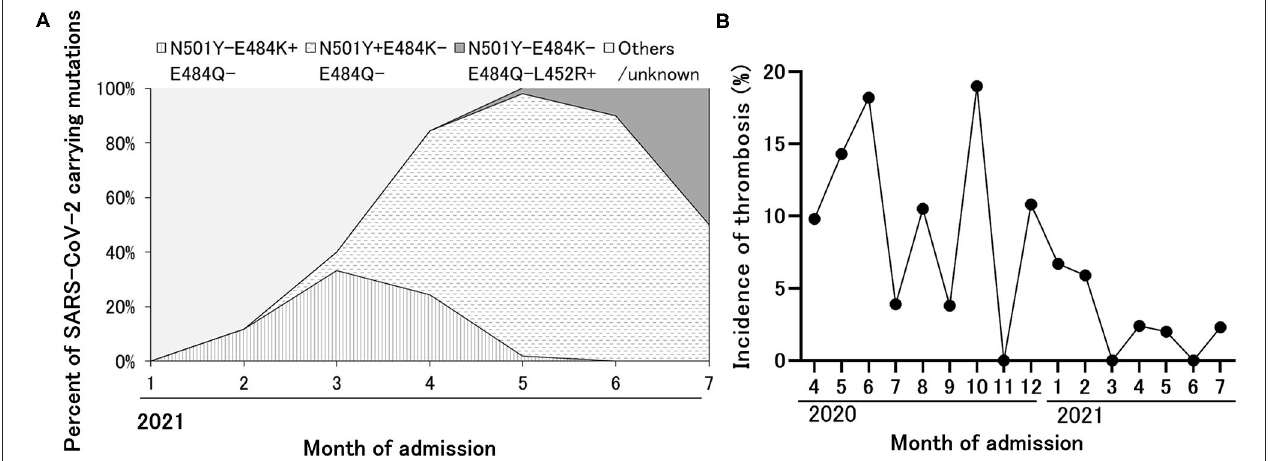
FIGURE 3 | The replacement of SARS-CoV-2 strain to VOC/VOI during the observation period and decreased incidence of thrombosis over time. (A) The expansion of variant strain of SARS-CoV-2 over time detected in the patients admitted with COVID-19. Based on the results of the epidemiologic analysis in Tokyo, the variant carrying E484K alone, N501Y alone, and L452R alone were considered as R.1 lineage variant, alpha variant, and delta variant, respectively. (B) The sequential change of the incidence of thrombosis during the observation